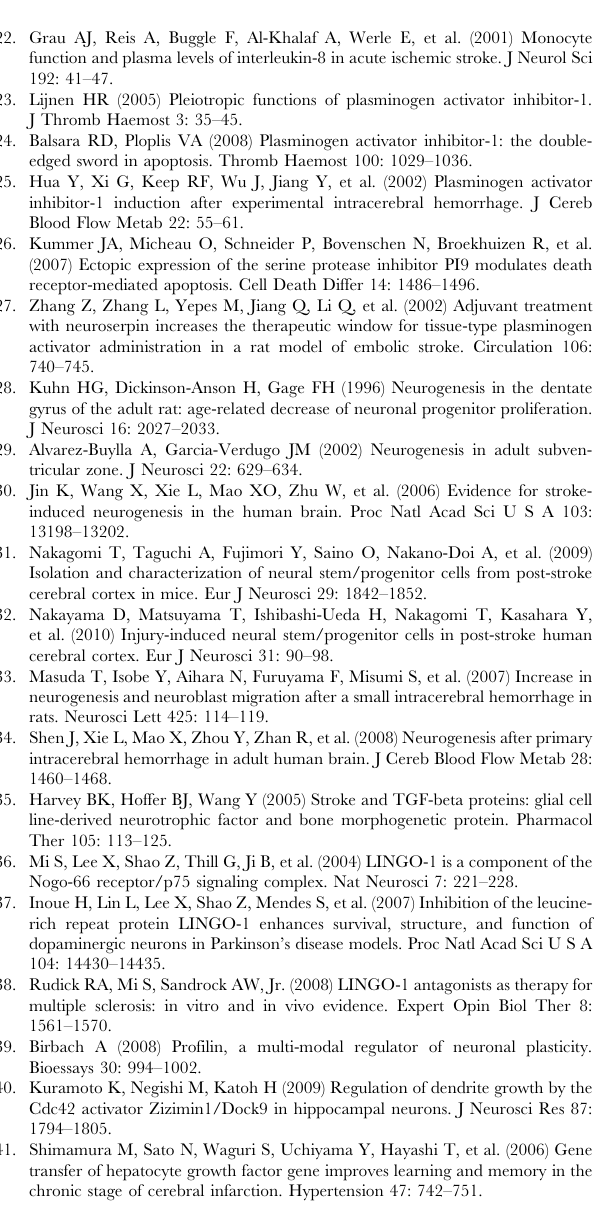
Table S3 Ingenuity Canonical Pathways showing a significant association [-Log(Pvalue) .